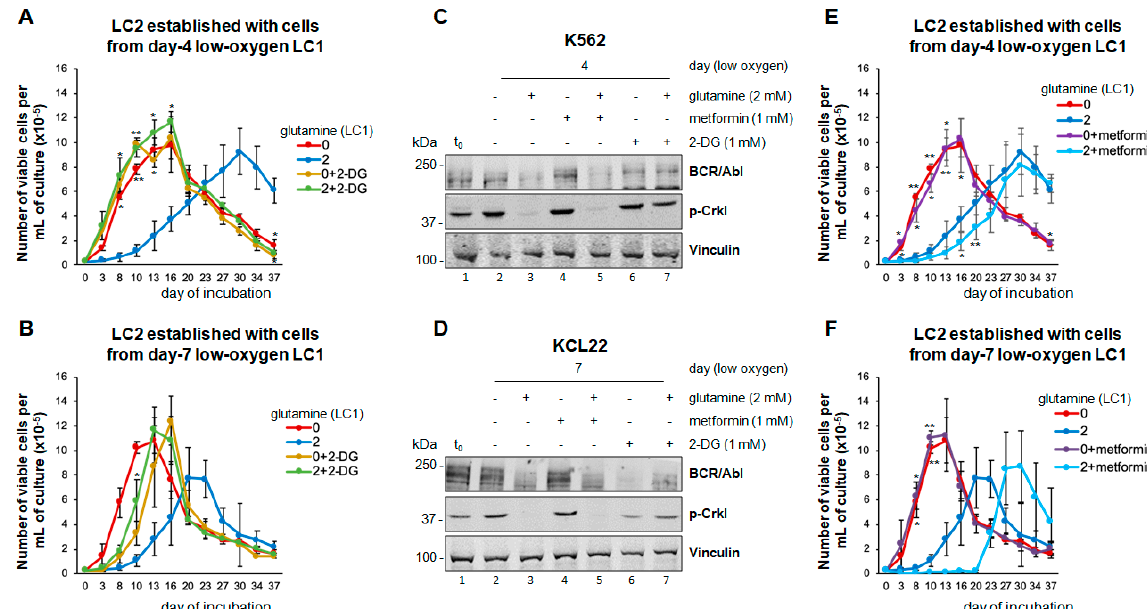
Figure 4. Effects of 2-DG or metformin on BCR/Abl expression/signaling and maintenance of stem cell potential in low oxygen in the absence or the presence of glutamine. K562 ( A , C , E ) or KCL22 ( B , D , F ) cells were seeded at 3 × 10 5 cells/mL and incubated in atmosphere at 0.2% O 2 for 4 or 7 days, respectively, in the absence (0/ − ) or the presence (2/+) of 2 mM glutamine and with or without ( − /+) the indicated compounds, added at time 0 of incubation (LC1). ( A , B , E , F ) LC1 cells were replated at 3 × 10 4 cells/mL into drug-free LC2 incubated at 21% O 2 and in any case in the presence of glutamine. Trypan blue-negative cells were counted at the times of incubation in LC2 indicated in abscissa. Values are mean ± S.D. of data obtained from 3 independent experiments; * p < 0.05, ** p < 0.01 vs. 2 mM glutamine/no drug. ( C , D ) Total cell lysates in Laemmli buffer were subjected to SDS-PAGE and immuno-blotting with anti-Abl or anti-p-Crkl Ab; anti-vinculin Ab was used to verify the equalization of protein loading. One representative experiment out of 3 with similar results is shown. The original Western blotting images and the relative densitometry values can be found in Supplementary Figure S2.